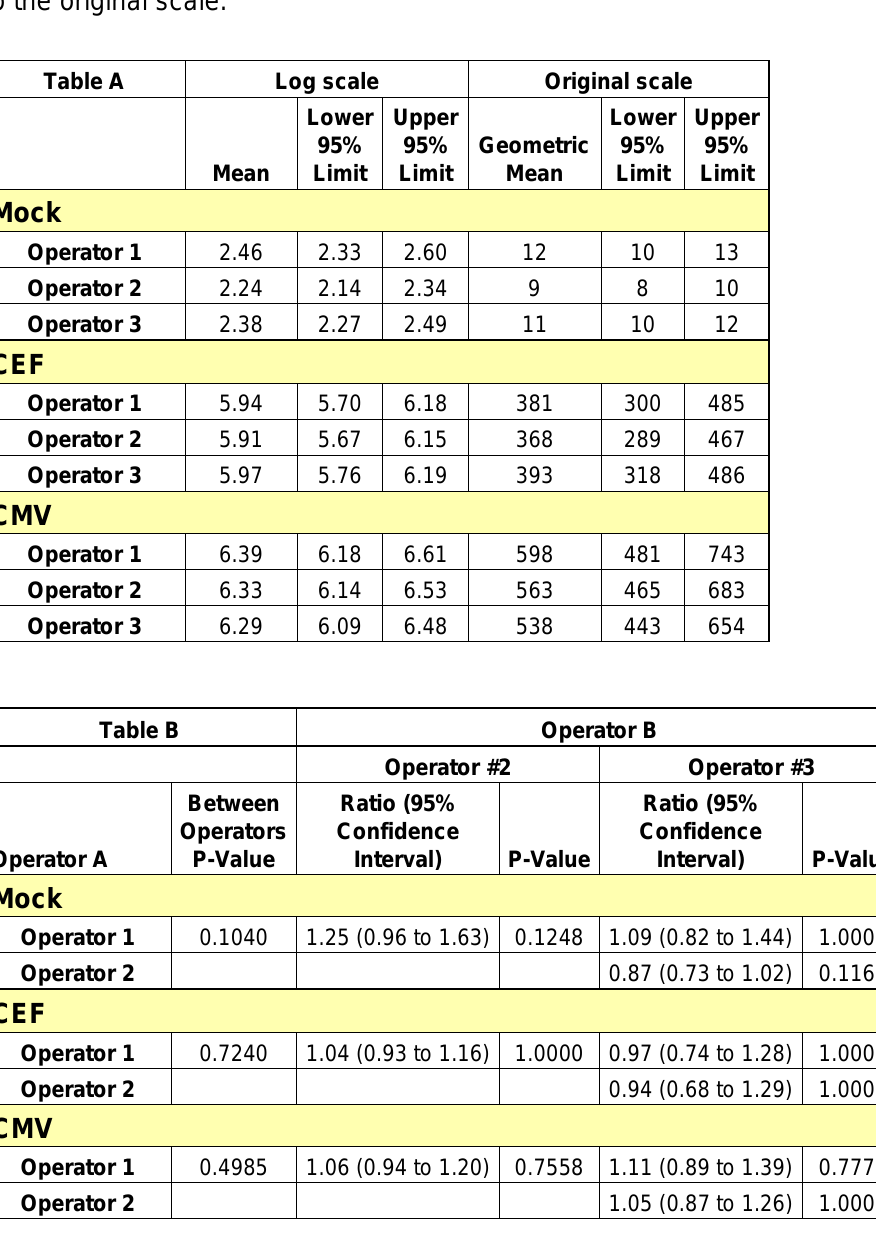
S4A Table: Least squares parameter estimates and adjusted (Bonferroni) 95% confidence intervals from repeated measures Poisson regression model. S4B Table: Pairwise comparison of least squares parameter estimates between operators, adjusted (Bonferroni) for multiple comparisons, from the same regression model as S4A Table above. Each cell shows the difference in least squares mean counts (Operator A - B) with 95% confidence intervals, exponentiated to the original